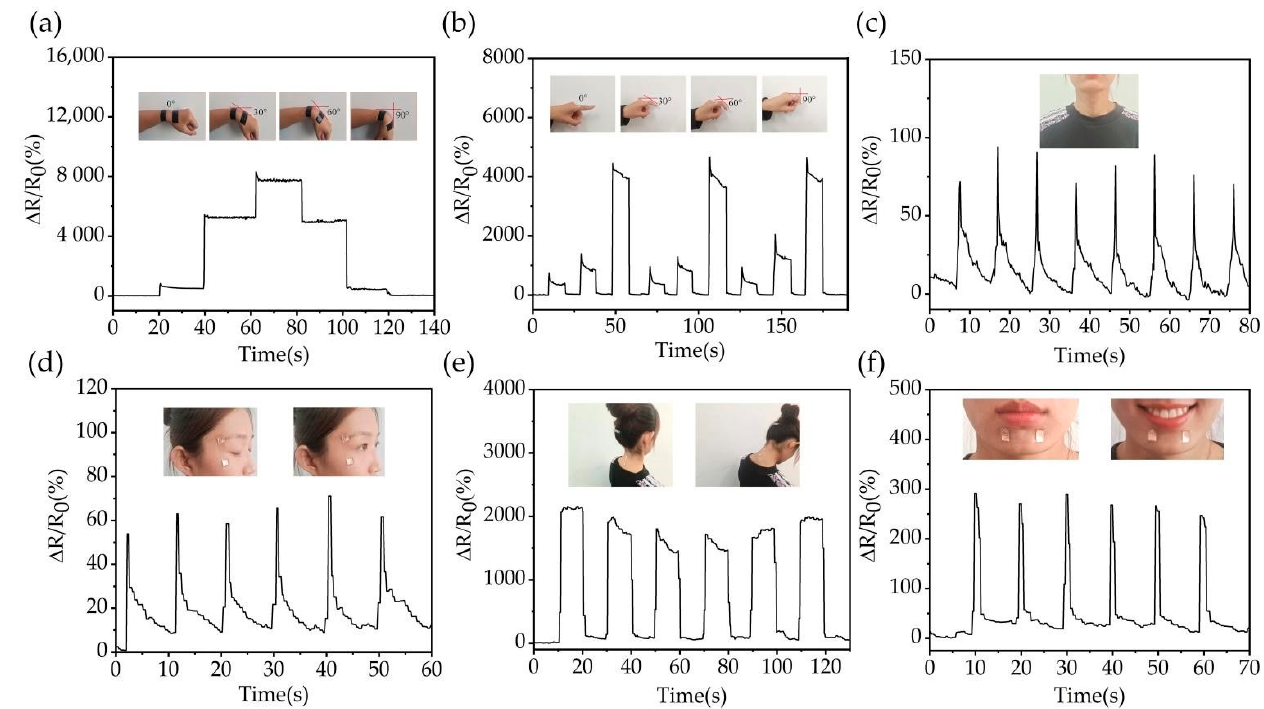
Figure 6. Applications of the strain sensor with the embedded MWCNT network in monitoring vari- ous human motions. Change of ∆ R/R 0 for: ( a ) bending of wrist, ( b ) bending of finger, ( c ) swallowing of food, ( d ) blinking, ( e ) bending of neck, and ( f )